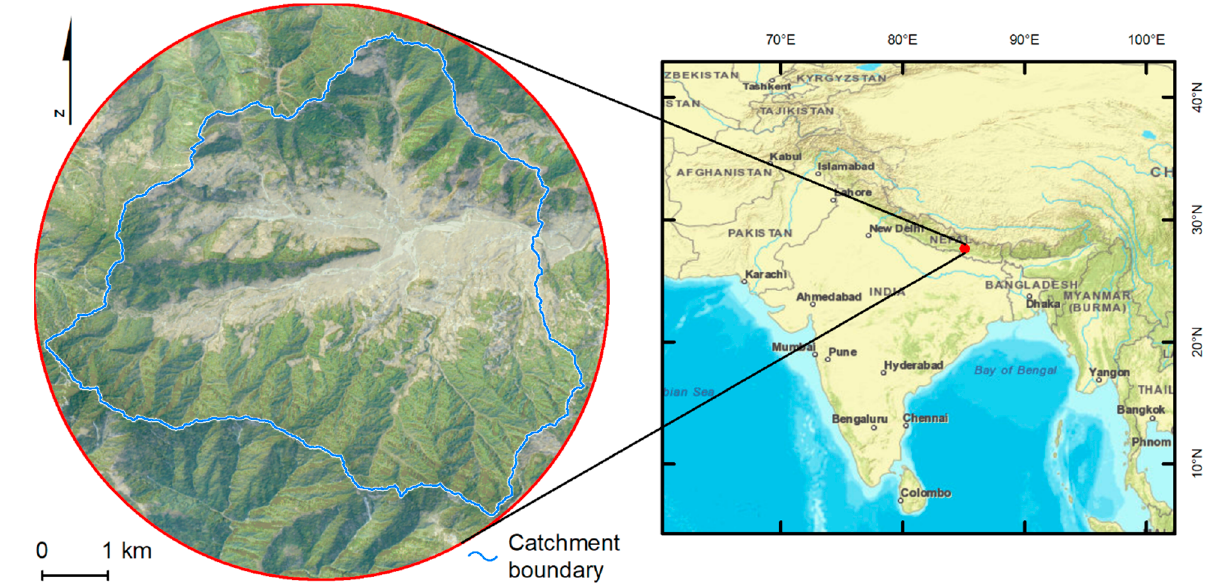
Figure 1. Location of the study area. Table 1. Local crop calendar of the study